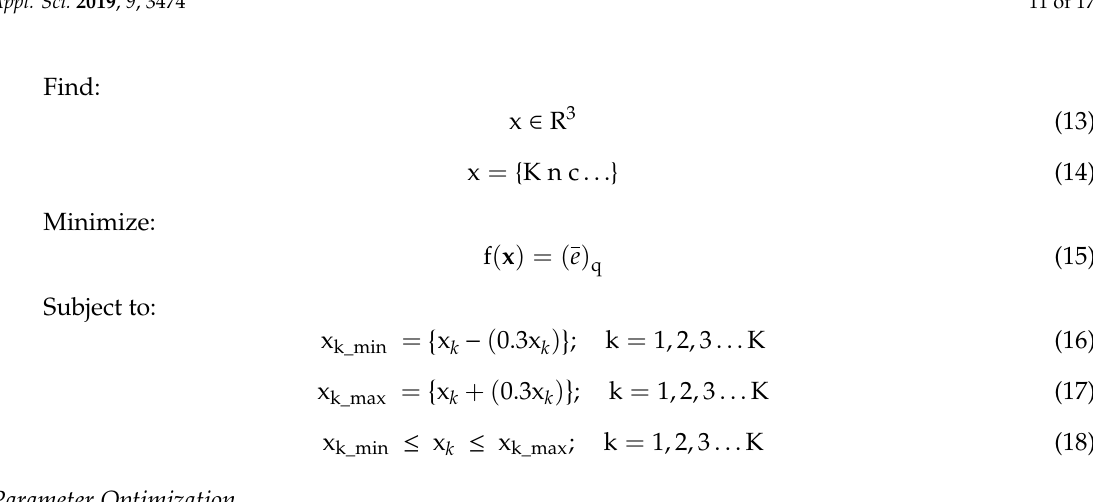
( b ) ( c ) Figure 9. Engineering S–S curve of the optimized models: ( a ) inverse models of GFRP wt 20%GF; ( b ) inverse models of GFRP wt 30% GF; ( c ) inverse models of GFRP wt 40% GF.